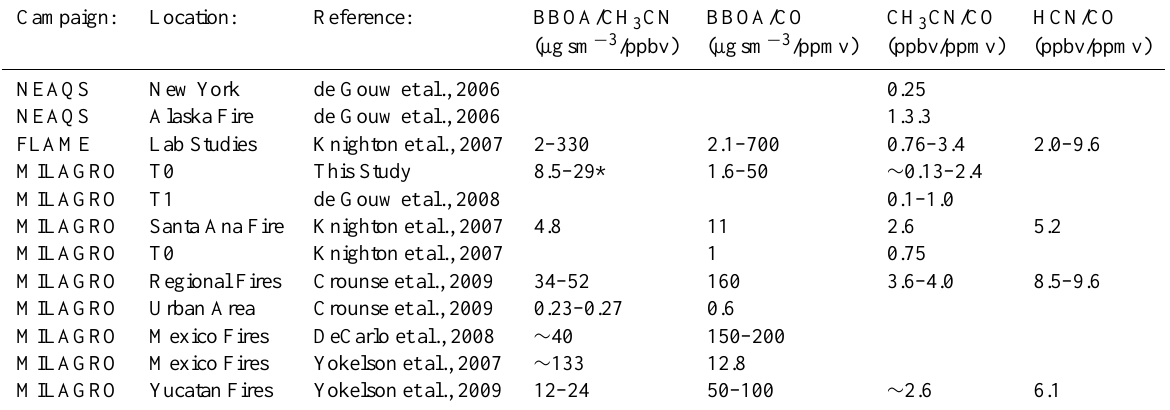
Table 2. Emission ratios from forest fire sources and measurements impacted by them measured both on the ground and by aircraft. (*: evaluated only for points with BBOA > 10µgam − 3 and using a background of 100pptv for acetonitrile). Particulate measurements, i.e. BBOA, are under STP (µgsm − 3 ) for ease of comparison to other locations.